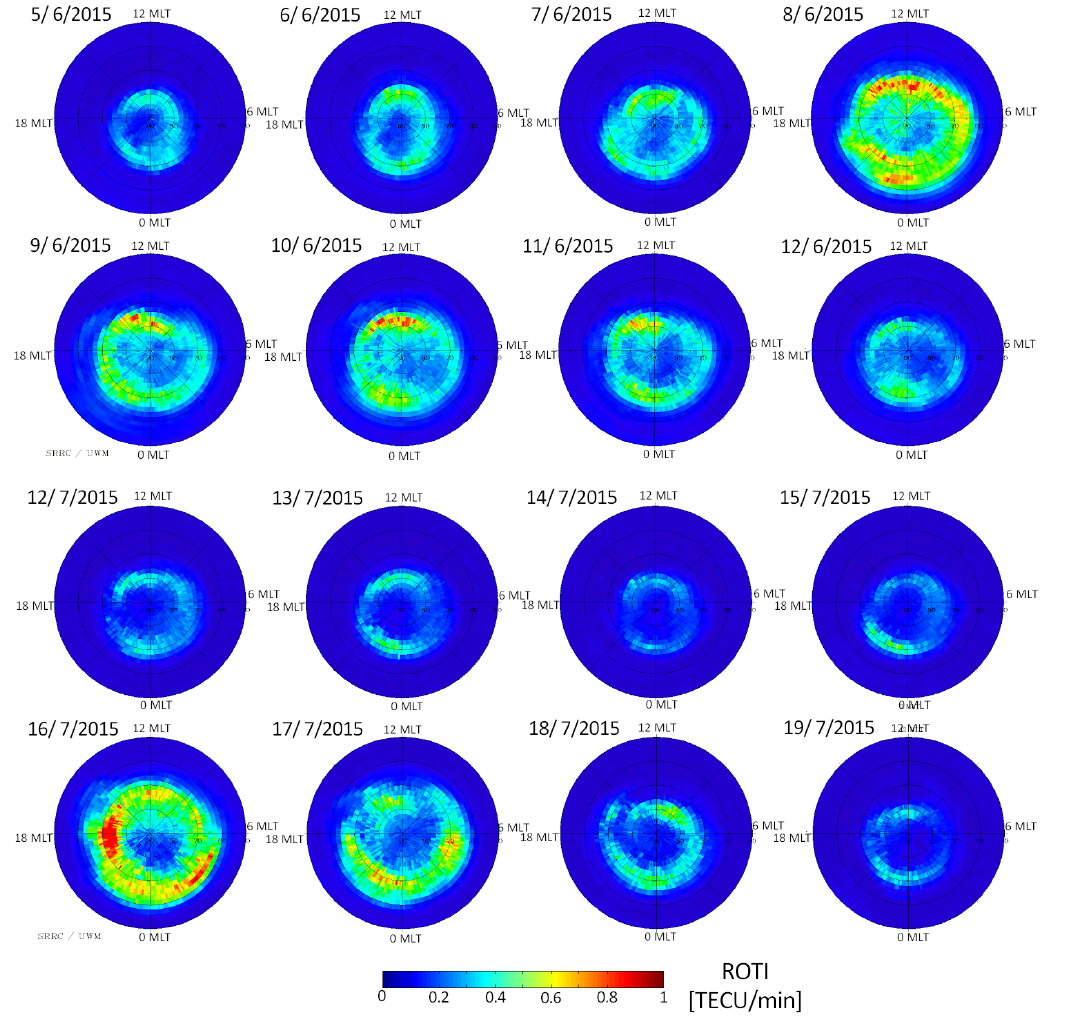
Figure 9. IGS ROTI product—auroral oval of the ionospheric irregularities (ROTI) for the 24 solar cycle maximum (2015, summer) and solar minimum for the same season. The maps cover 50 ◦ –90 ◦ N MLat with 10 ◦ latitude circles; magnetic local noon/midnight is at the top/bottom, and dusk/dawn is toward the left/right. Source: